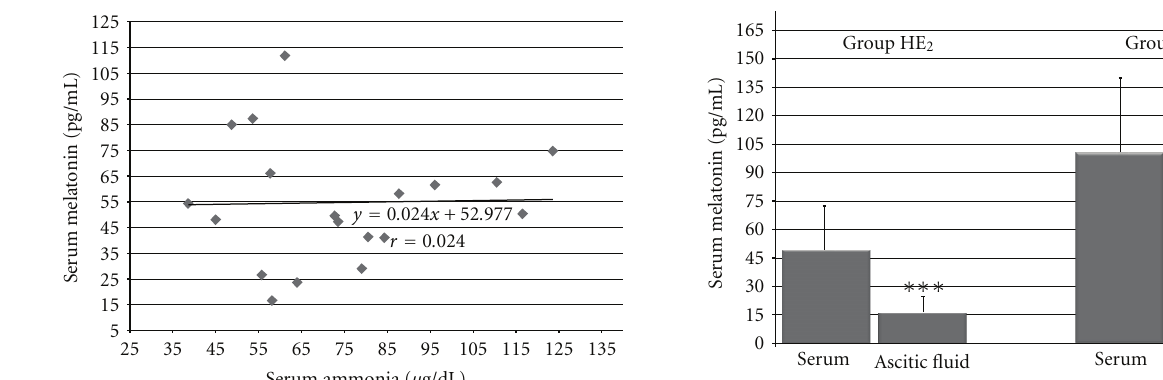
Figure 3: Correlation between ammonia and melatonin serum lev- els in cirrhotic patients with 2nd degree of hepatic encephalopathy (group HE 2 ) according to West-Haven Score; y : regression equa- tion, r : correlation coe ffi cient, statistically insignificant.